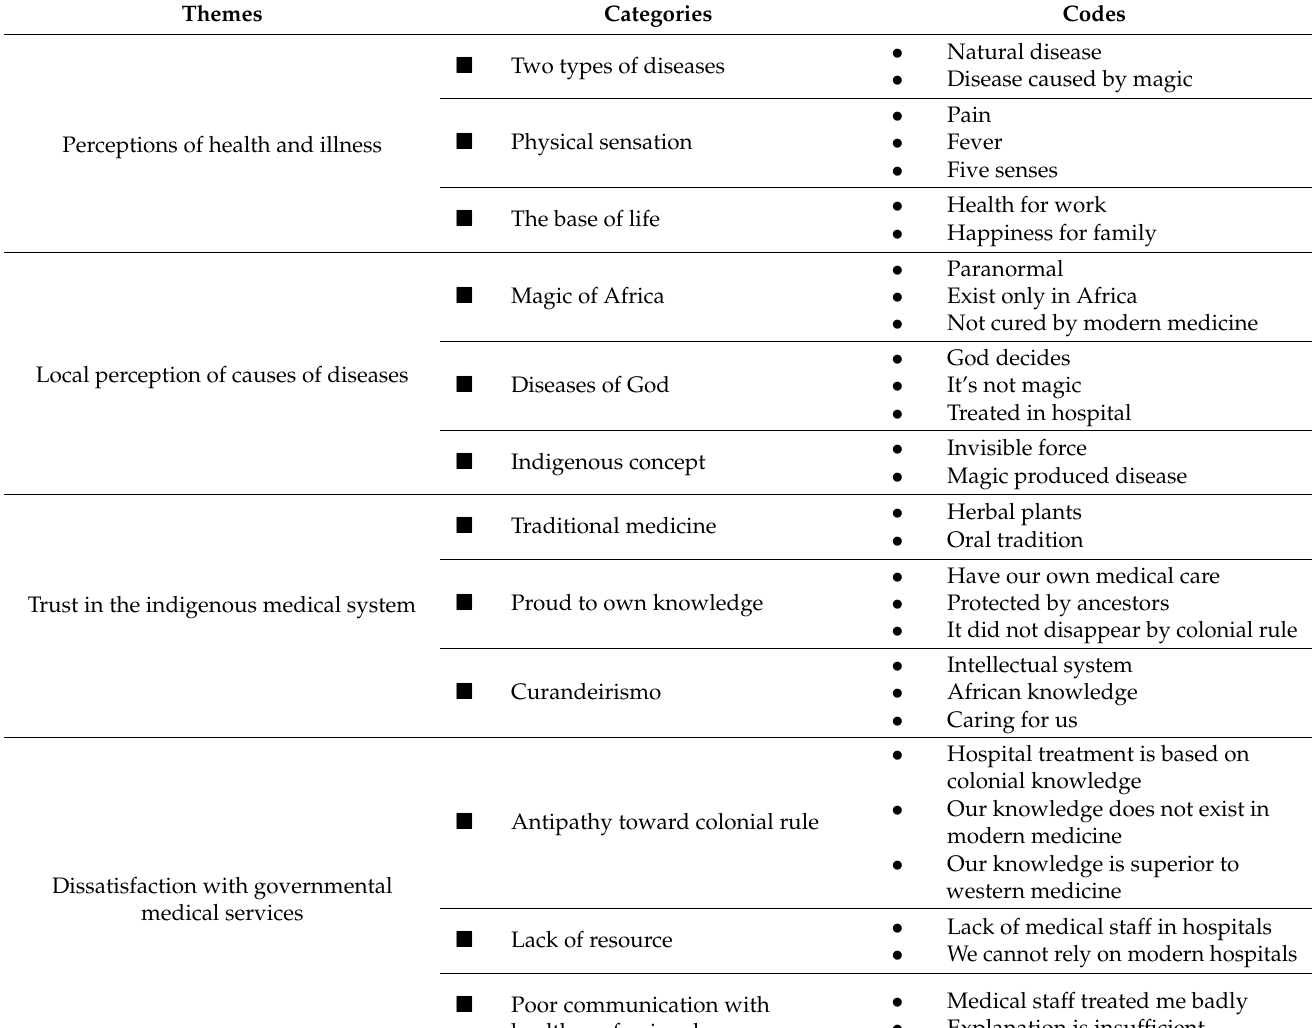
Table 3. Themes, categories, and